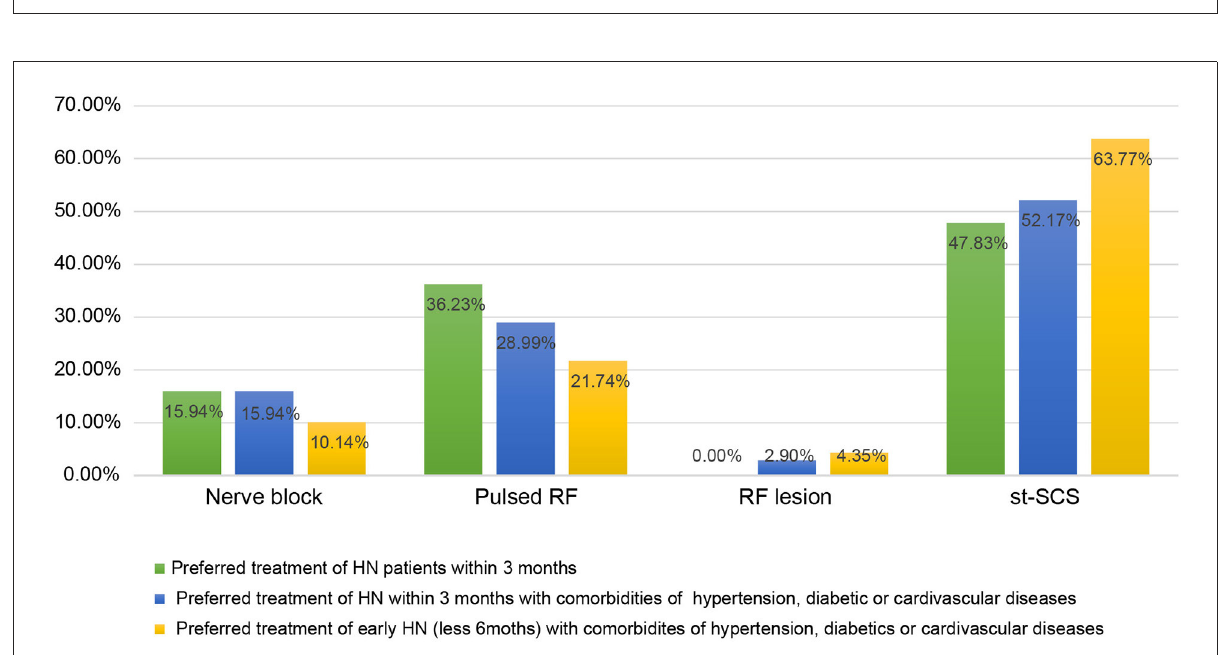
FIGURE7 The preferred approaches for HN treatment among the techniques of nerve block, nerve pulsed RF, nerve radiofrequency lesion, and st-SCS. More experts agreed that st-SCS was the preferred treatment for HN within 3 months, especially for HN or early PHN patients with comorbidities of hypertension, diabetes, or cardiovascular disease, compared with nerve pulsed RF, nerve block, or nerve radiofrequency